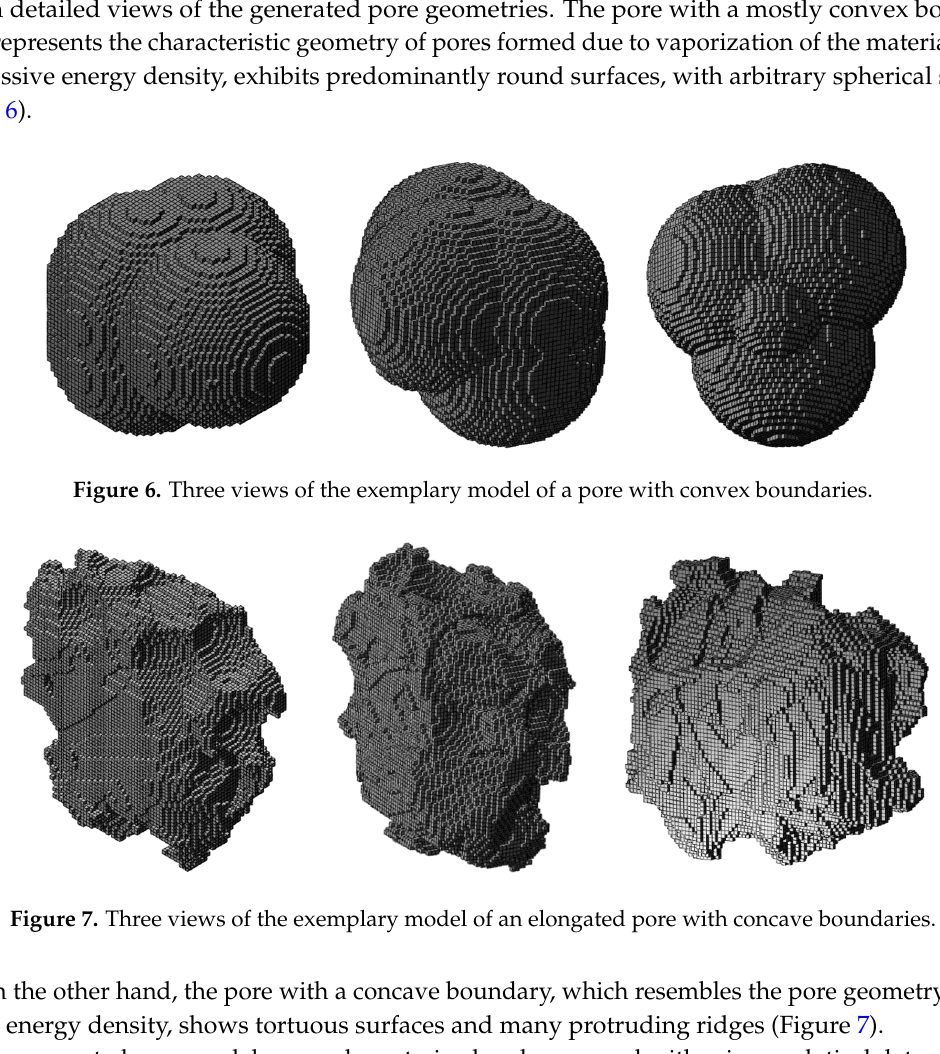
Figure 7. Three views of the exemplary model of an elongated pore with concave boundaries.